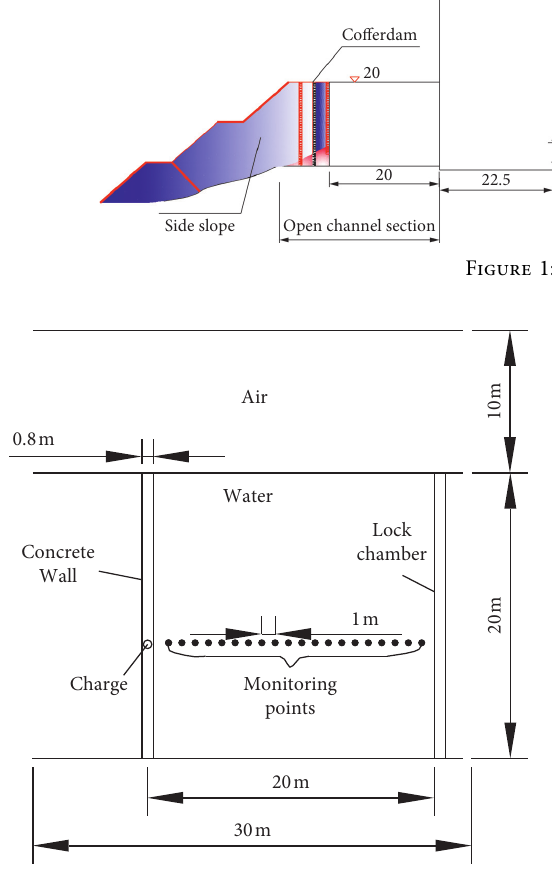
Figure 2: Schematic diagram of the calculation